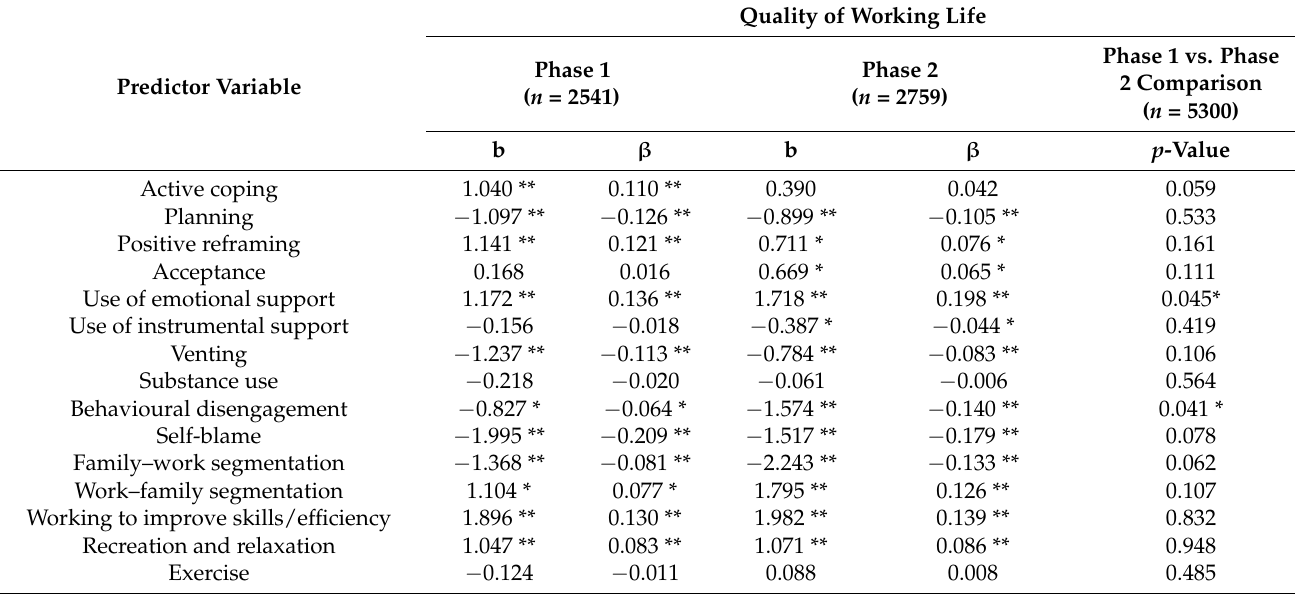
Table 4. Multiple group regression analysis examining coping strategies as predictors of quality of working